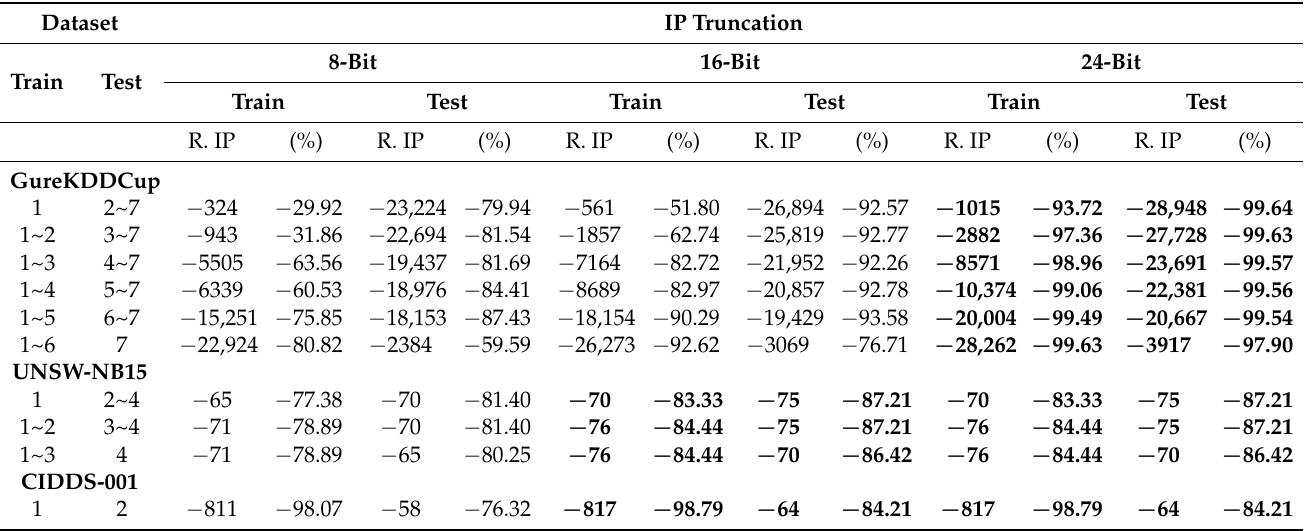
Table 8. Performance Comparison (Total Number of Distinct IP address) for each C4.5 Model in Full GureKDDCup’99, UNSW-NB15, and